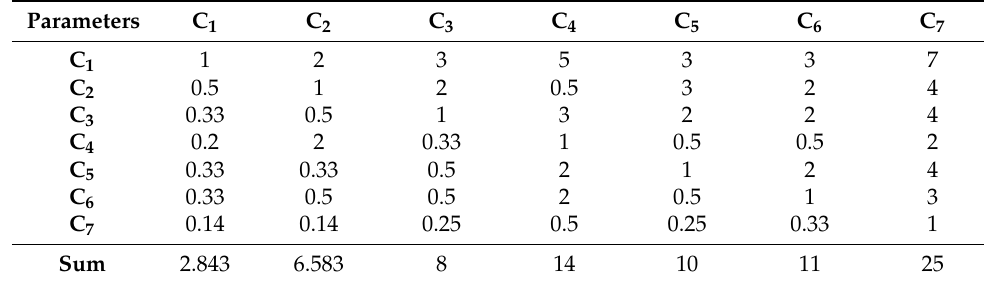
Table 6. Pairwise comparison matrix.